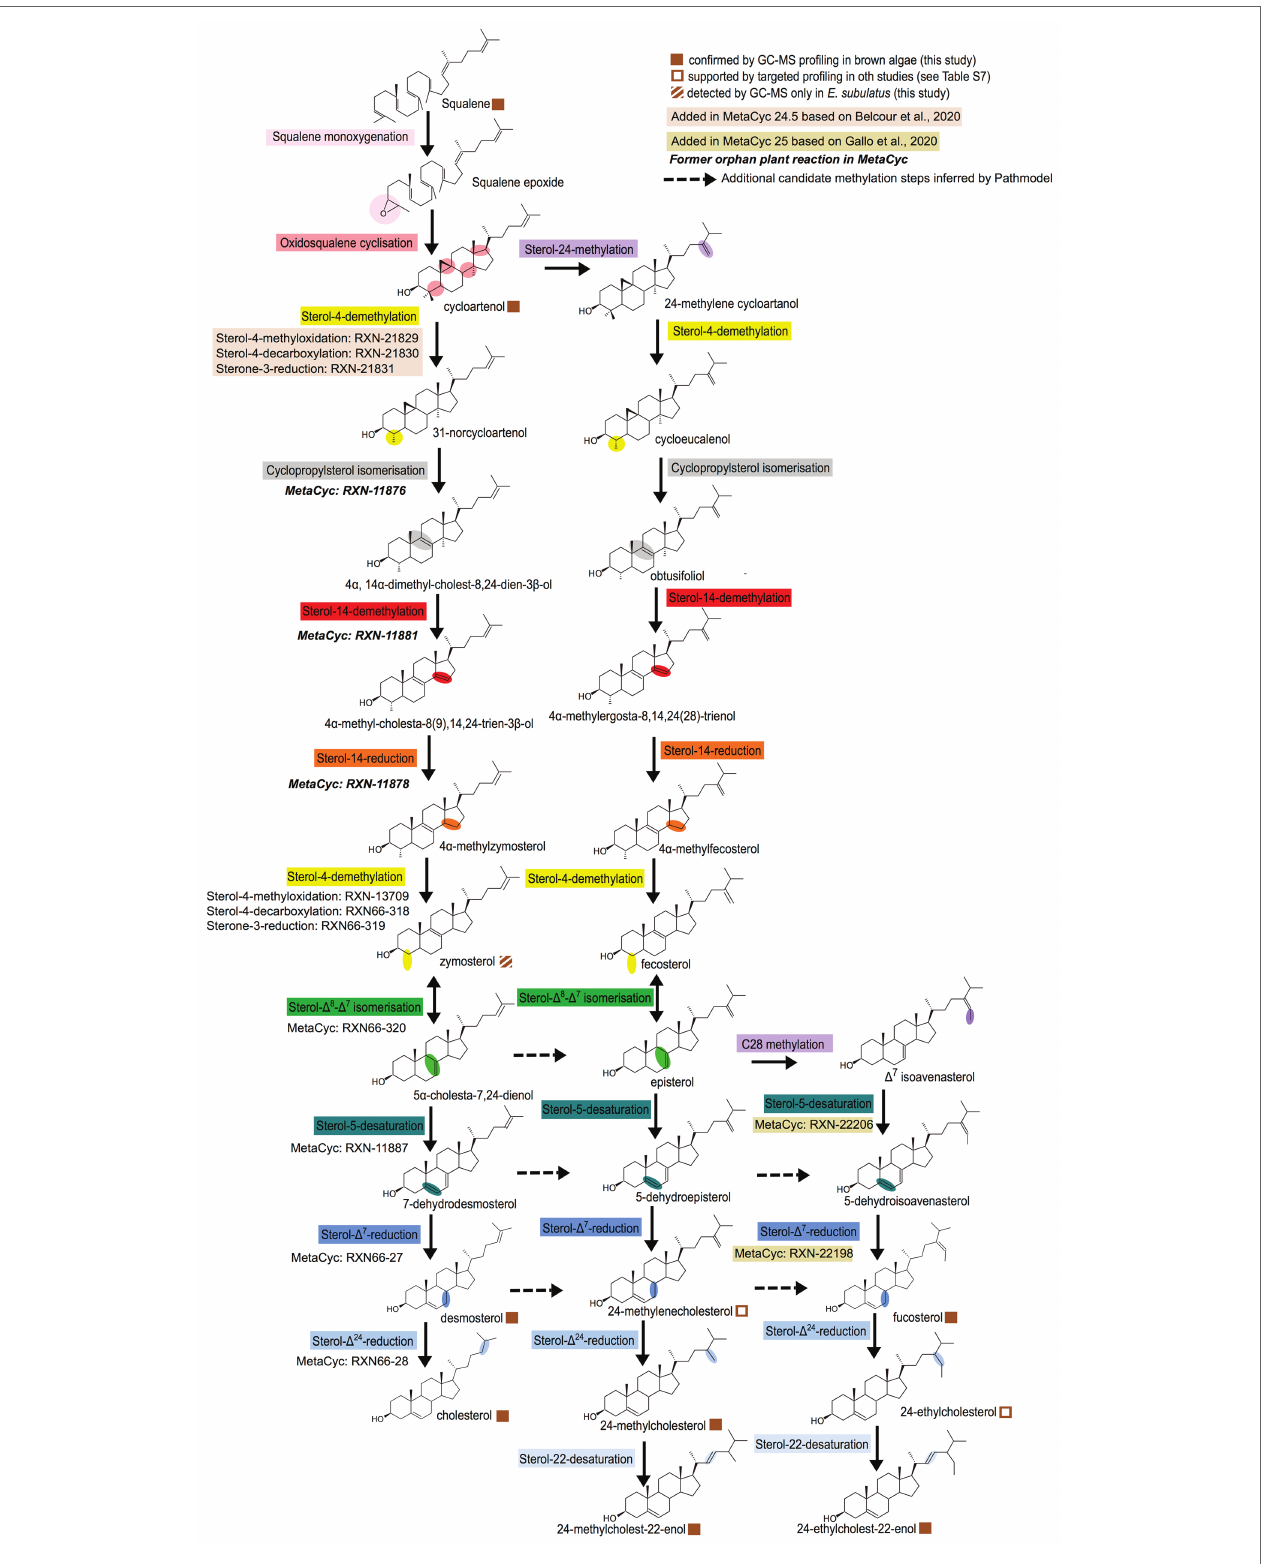
FIGURE 2 | General model for sterol biosynthesis in brown algae. The model was generated with Pathmodel, using the end metabolites isolated by GC-MS as targets and using known reactions. The colors indicate similar molecular transformations occurring on different substrates in the various pathway